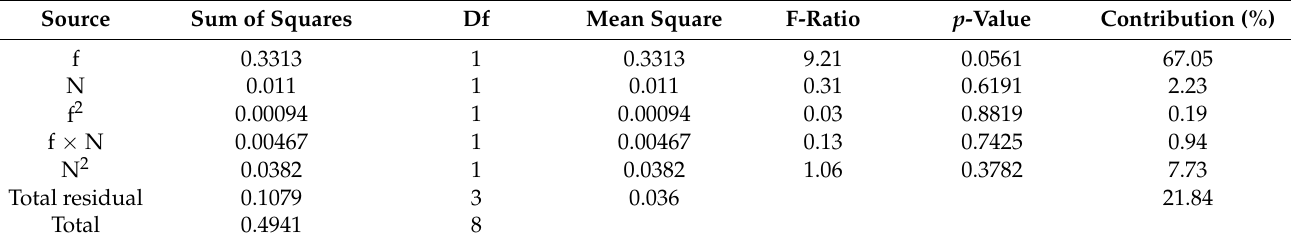
Table 6. Analysis of variance for Ra_PEEK-GF30.